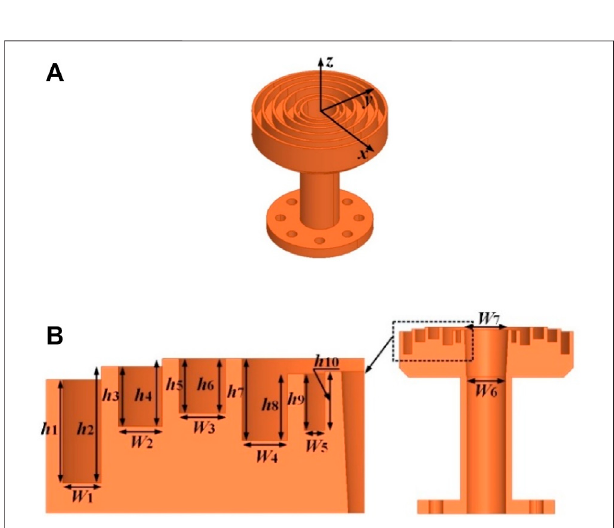
FIGURE4| Simulationmodeloftheproposedcorrugatedhornantenna. (A) 3-D view. (B) Section